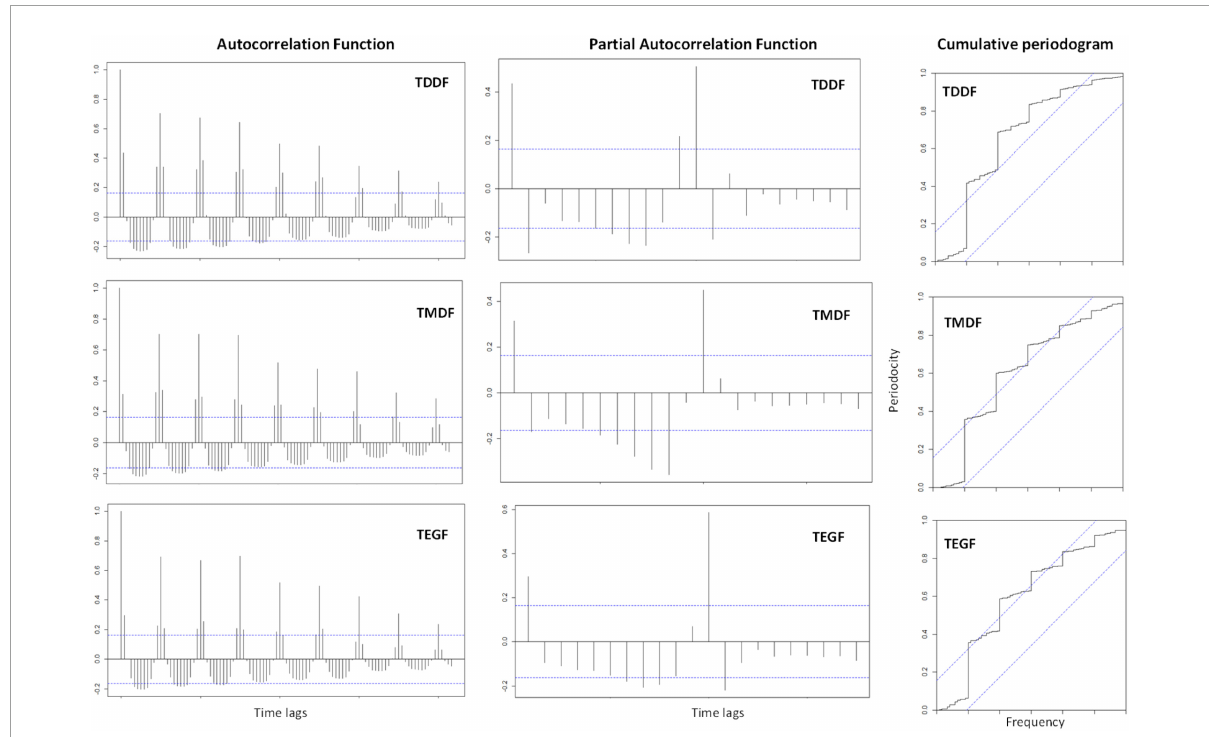
FIGURE4 Autocorrelation function and partial autocorrelation function (100 lags) and cumulative Periodogram for Tropical Dry Deciduous Forests (TDDF), Tropical Moist Deciduous Forests (TMDF), and Tropical Evergreen Forests (TEGF).